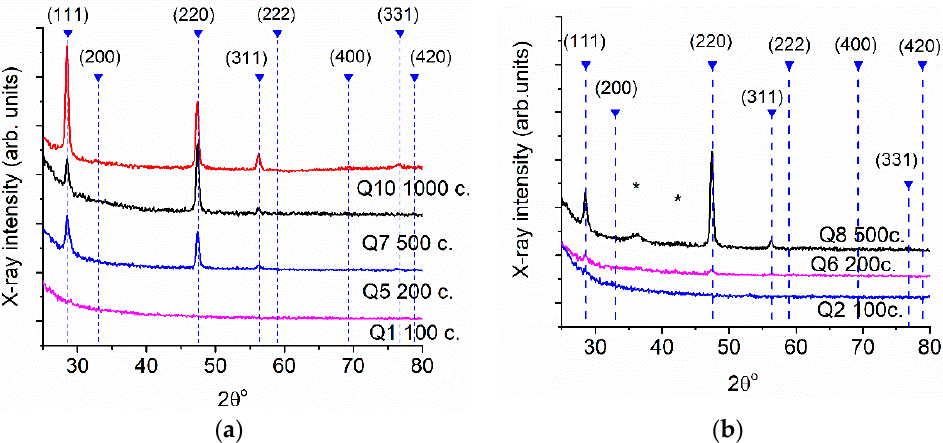
Figure 3. XRD spectra of ( a ) uncapped and ( b ) capped CuCl films on quartz substrates. Unidentified peaks marked with asterisks. Note: The “missing” CuCl peaks ((200), (222), (400), and (420)) have low intensities compared to the (111) peak for randomly oriented material (PDF 1010991).